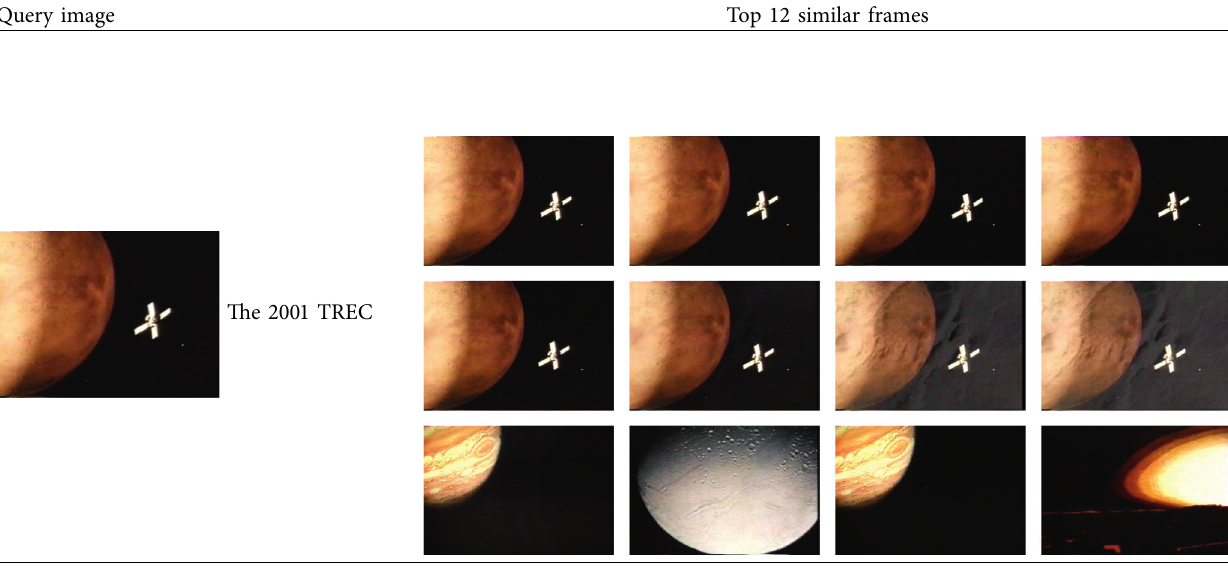
Table 4: Example of the top 12 similar frames for the query image on the 2001 TREC. Query image